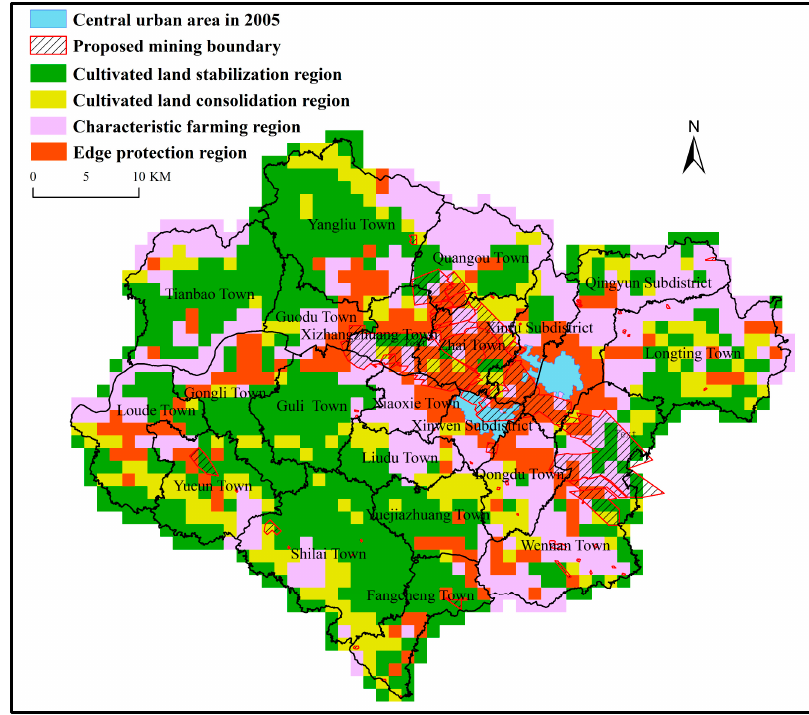
Figure 9. Spatial distribution of cultivated land zoning identi fi cation results.